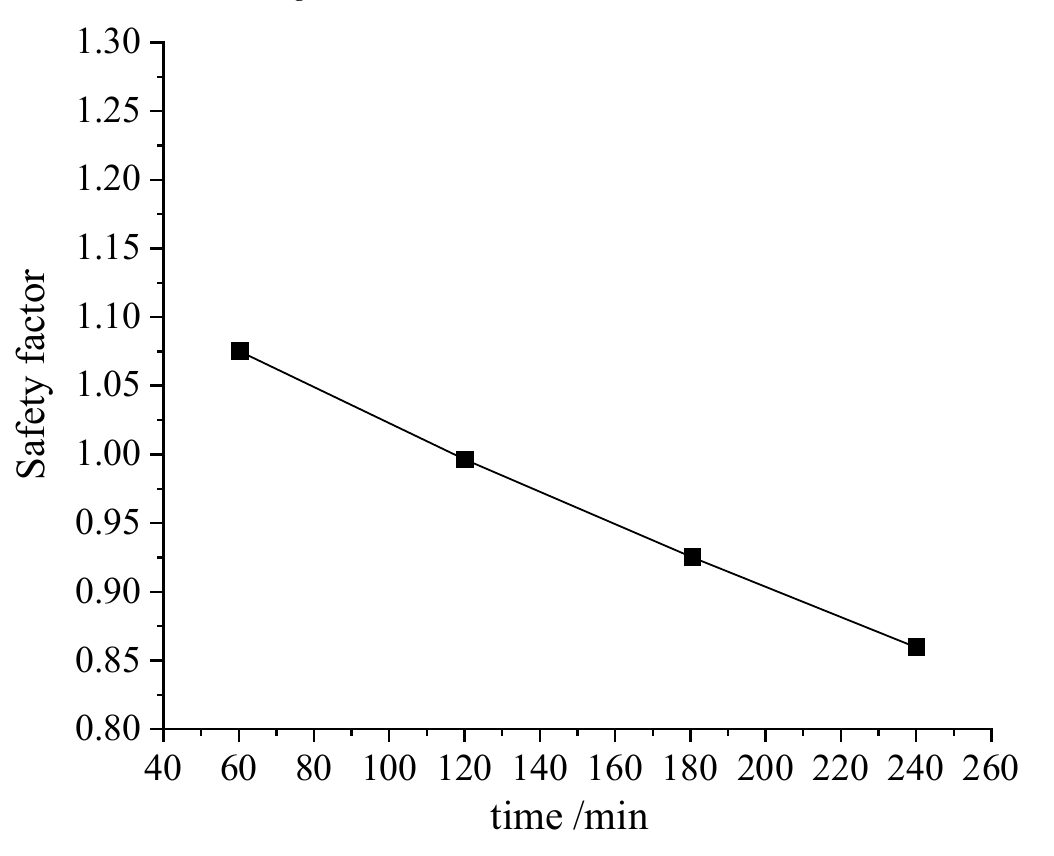
Figure 17. The diagram of safety factor under different time under